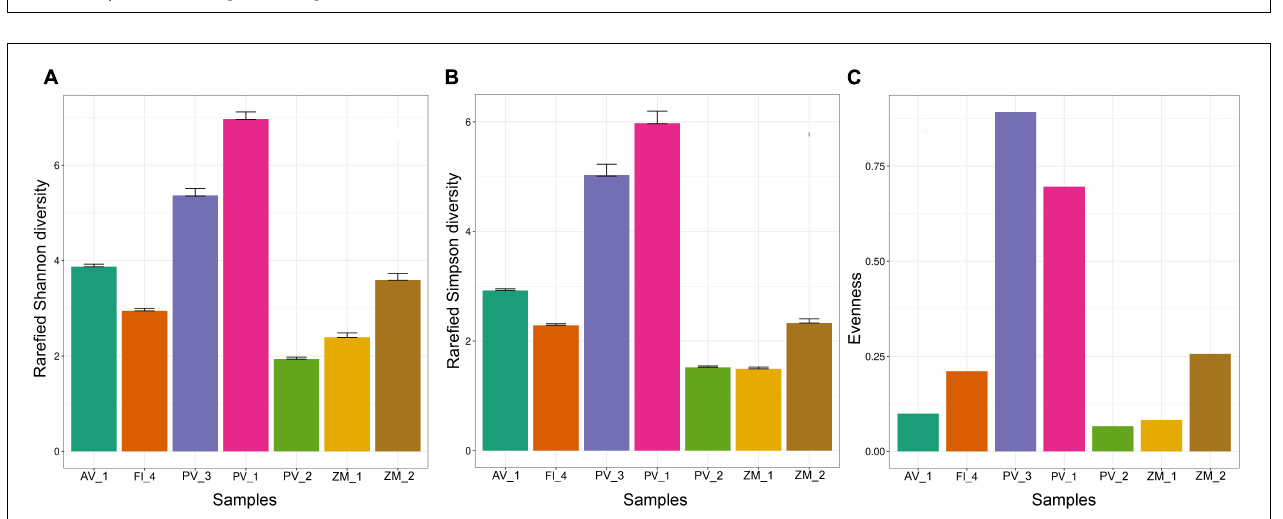
FIGURE 6 | Alpha diversity metrics of fungal ASVs in sediment samples from deep-sea low- and high-temperature hydrothermal vents, and oxygen minimum zones, depicting rarefied Shannon (A) and Simpson (B) indexes, and evenness (C) .